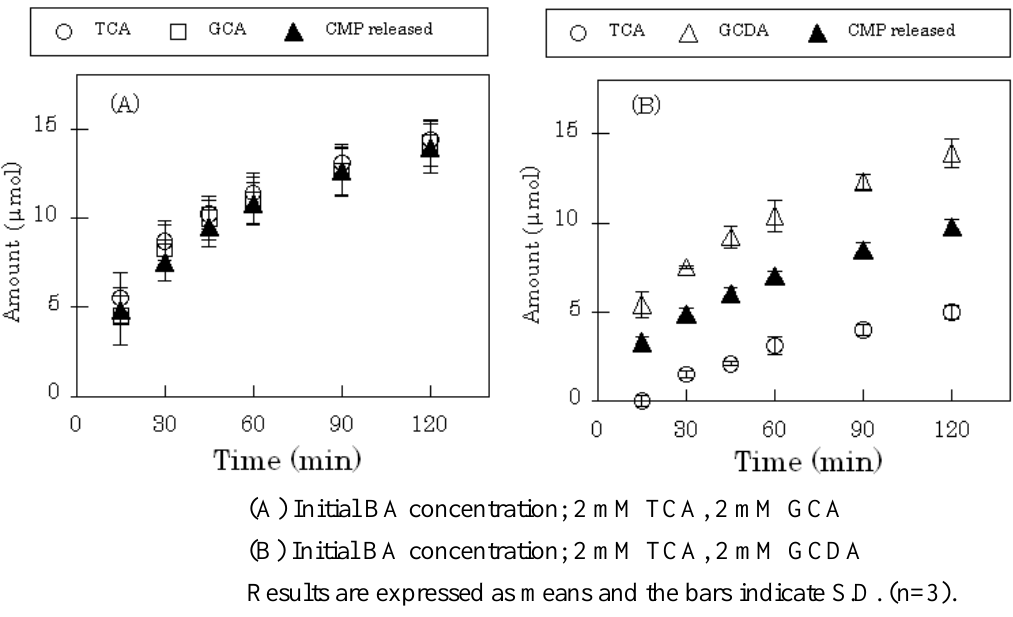
Figure 4. Uptake of BAs into dried Alg-Ca containing CS-CMP.